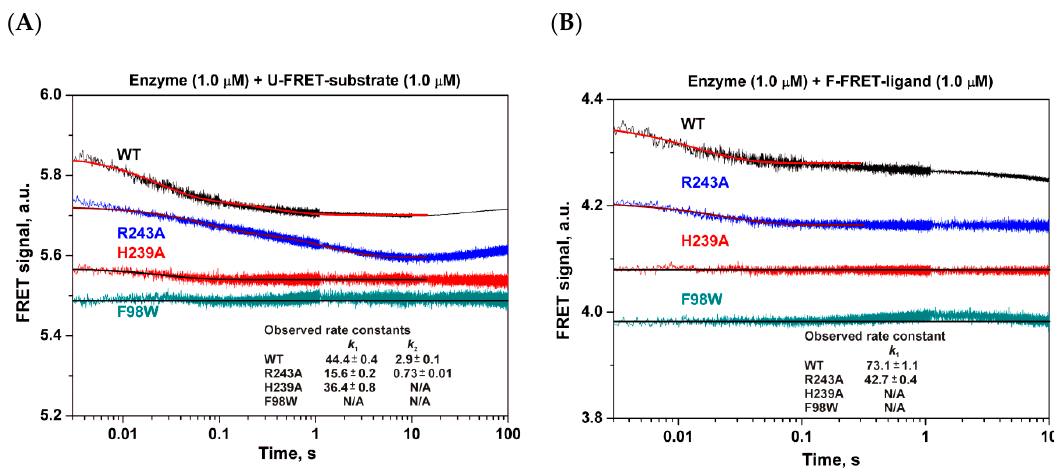
Figure 7. The interaction of WT hSMUG1 or of the mutants with DNA duplexes containing a Ura base ( A ) or F-site ( B ). Concentrations of the enzymes and DNA are indicated in the panels.